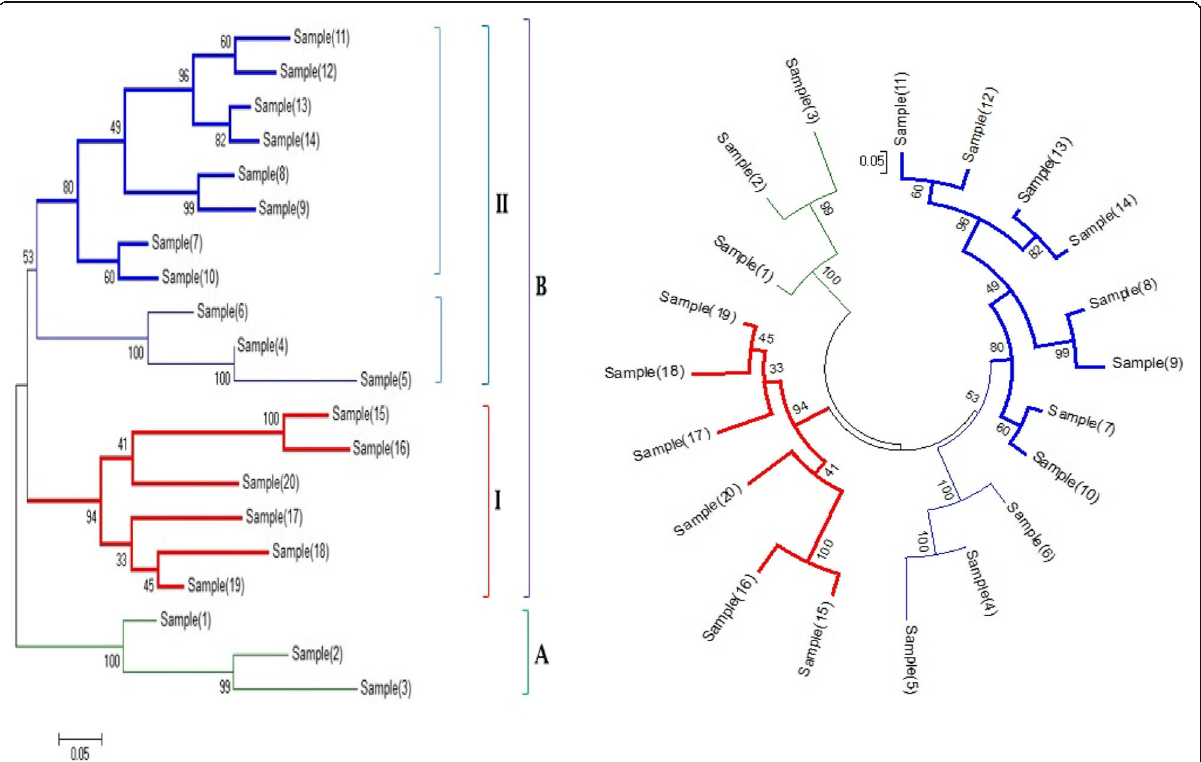
Fig. 5 Molecular Phylogenetic analysis of different Triticum species by pairwise distance analysis depending on amino acid sequence of maturase- like protein. The phylogenetic analysis was performed in MEGA version 6 program by maximum likelihood method depending on the JTT matrix- based model (Jones, et al. 1992). The tree had the highest log likelihood ( − 2539.1376). The tree ’ s percentage in which the associated species clustered together is shown next to the branches. Initial tree(s) for the heuristic search were performed automatically by applying Neighbor-Join and BioNJ algorithms to a matrix of pairwise distances estimated using a JTT model and then selecting the topology with superior log likelihood value. The tree is drawn to scale with branch lengths measured in the number of substitutions per